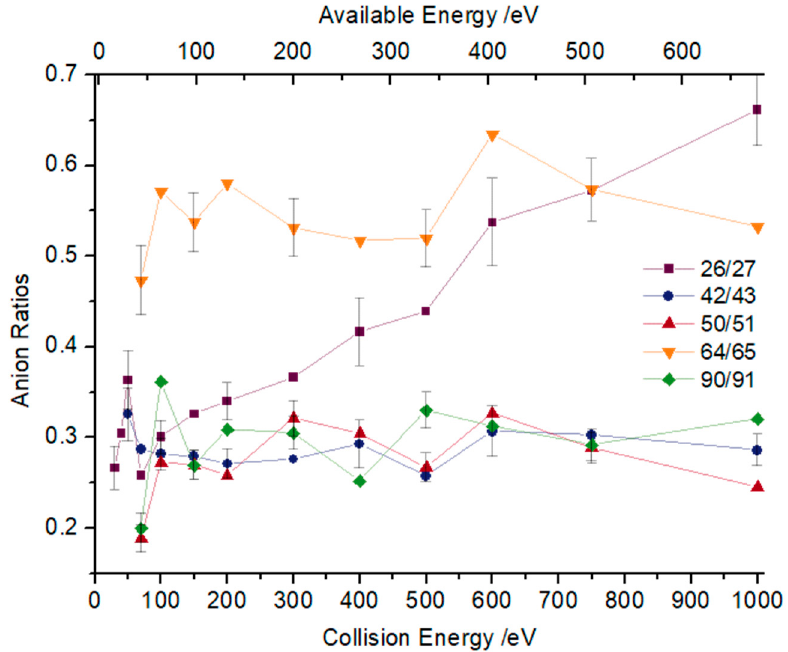
Figure 3. Ratio between the yield of relevant anions that differ by one m/z as a function of the energy. Error bars related to the experimental uncertainty associated with the ion yields have been added to a few data points in order to avoid congestion of the figure. The lines are just to guide the eye. Table 1. Assignment of negative ions formed in neutral potassium collisions with phenyl boronic acid (PBA) and cyclohexyl boronic acid (CHBA).